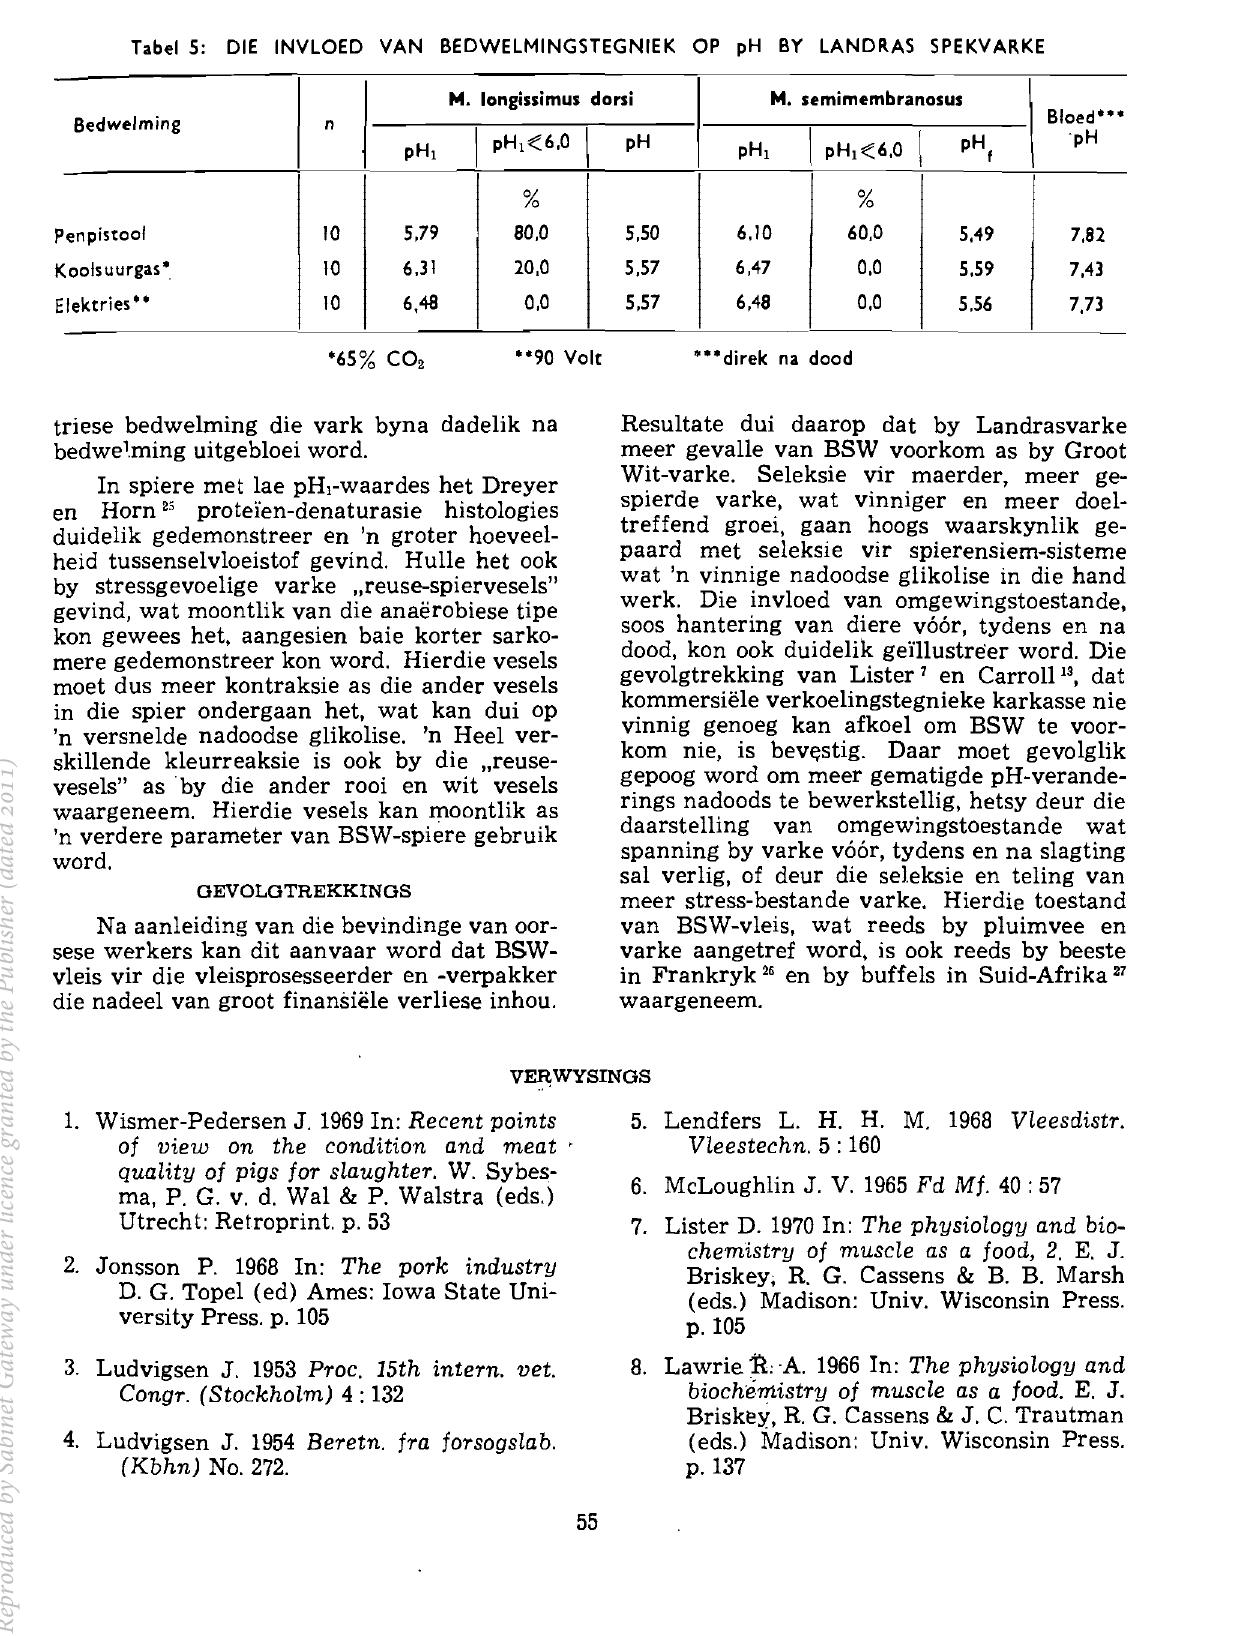
Tabel 5: DIE INVLOED VAN BEDWELMINGSTEGNIEK OP pH BY LANDRAS